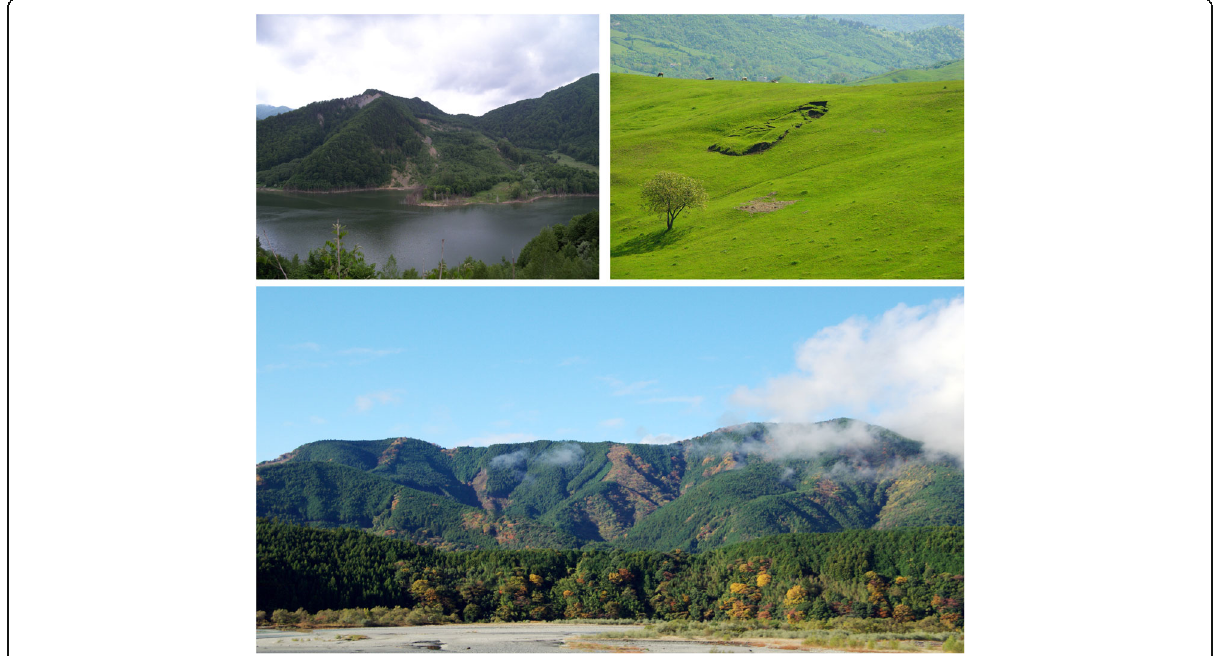
Fig. 2 High magnitude deep-seated landslides in the Buz ă u Carpathians, upper left; low magnitude, clearly individualized shallow earth slide in the Buz ă u Subcarpathians, upper right; mountain slopes with historical landslides, that are mostly covered by vegetation in Shizuoka Prefecture, lower